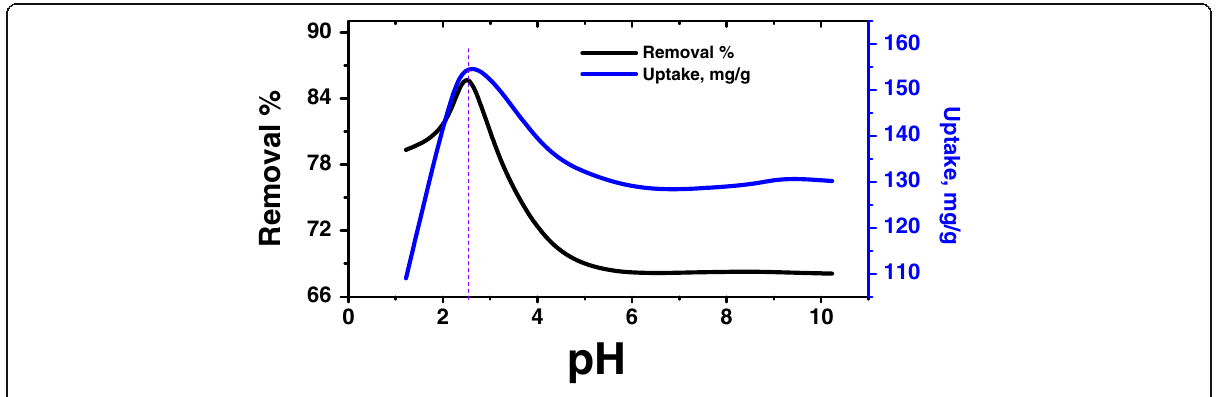
Fig. 5 Effect of solution pH on adsorption of AO67 onto RPSF